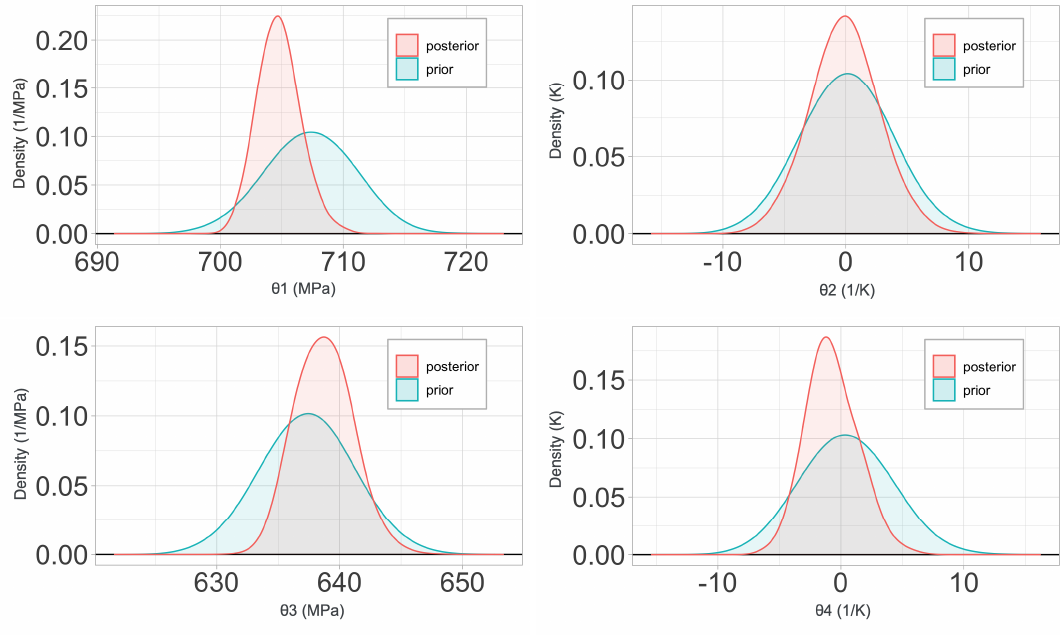
Figure 15. Prior vs. posterior parameter probability distributions for C 0 ∼ θ 1 , C 3 ∼ θ 2 , C 5 ∼ θ 3 , n ∼ θ 4 , of the ZA model considering ∆ R as the